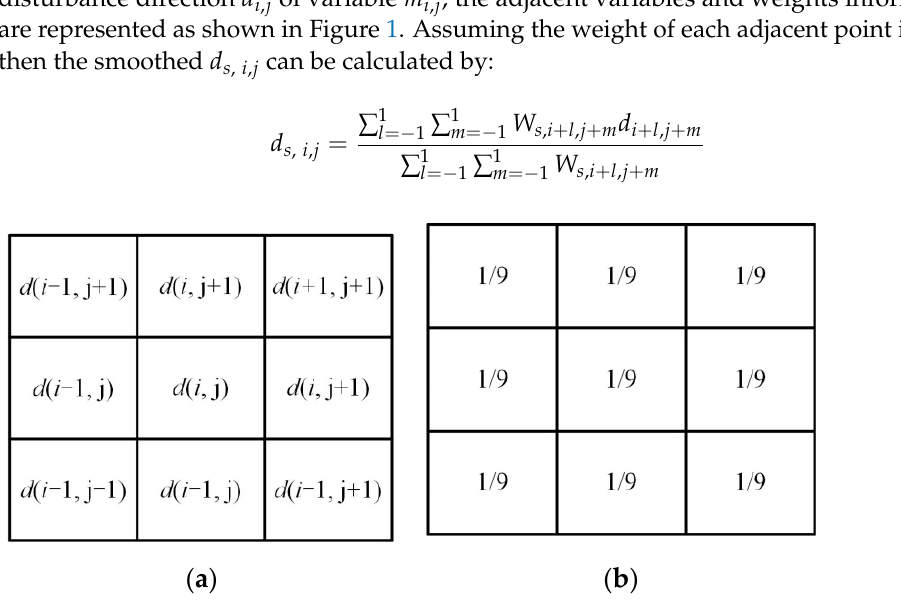
Figure 1. Square-shaped window of perturbation direction d i , j . ( a ) d i , j ’s neighborhood; ( b ) The weight information for d i , j and its adjacent position.